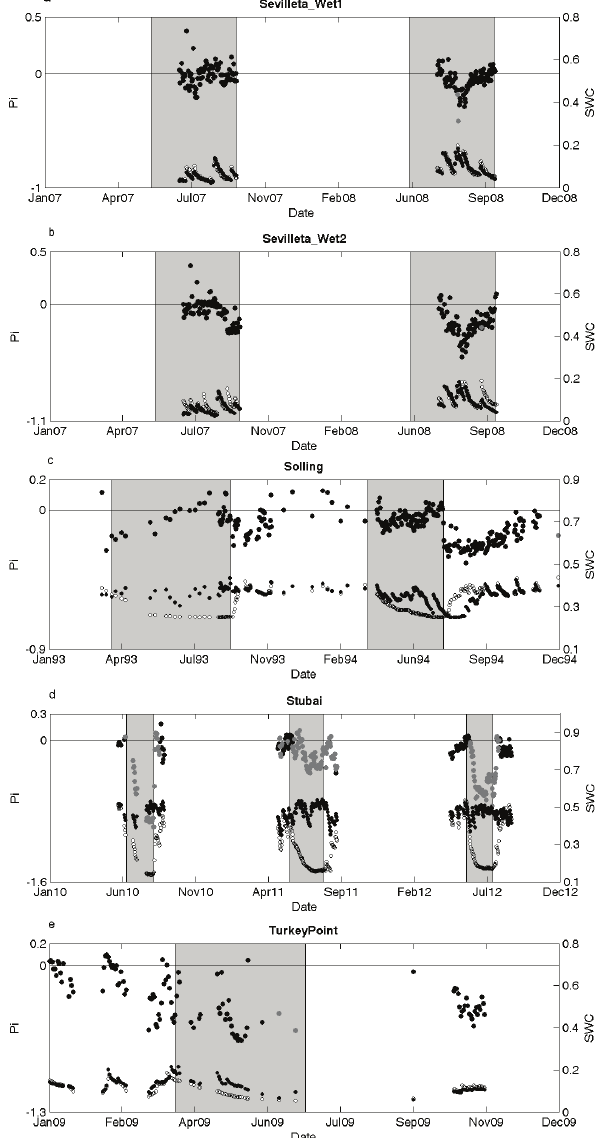
Figure 5. Time course of Pi (predictability index, large black and gray circles) for the five experiments for which our hypothesis was rejected and for which a significant trend was detected: (a) Sevil- leta_ Wet1, (b) Sevilleta_ Wet2, (c) Solling, (d) Stubai and (e) TurkeyPoint. Pi values close to zero indicate that SCE treatment was predicted similarly well compared to SCE control , whereas values substantially below or above zero indicate the difference in pre- dictability of SCE treatment relative to SCE control . Negative values indicate that the prediction of SCE treatment was worse than that of SCE control , and vice versa for positive values. Large gray circles indicate when SWC treatment was outside the range of SWC control . Small black and white circles represent the soil water content (SWC) for control and treatment plots, respectively. Gray areas in- dicate the time when water inputs were